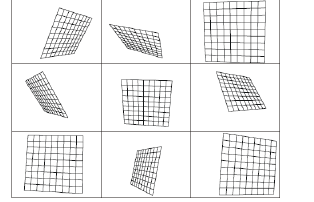
Figure 1. Some two vanishing points images (Lazaros et al.,